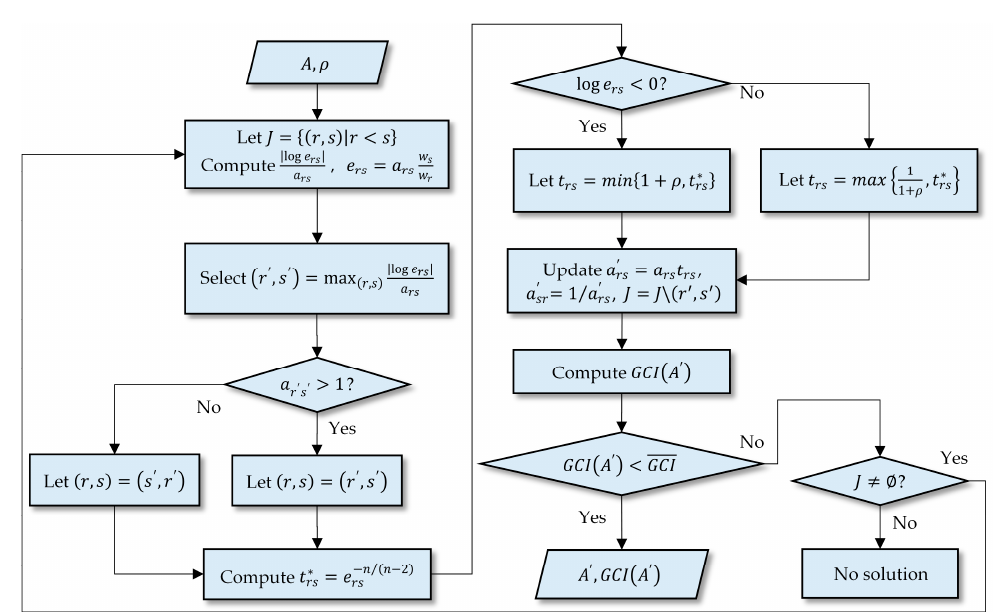
Figure 6. Flow chart of the individual consistency improvement algorithm.